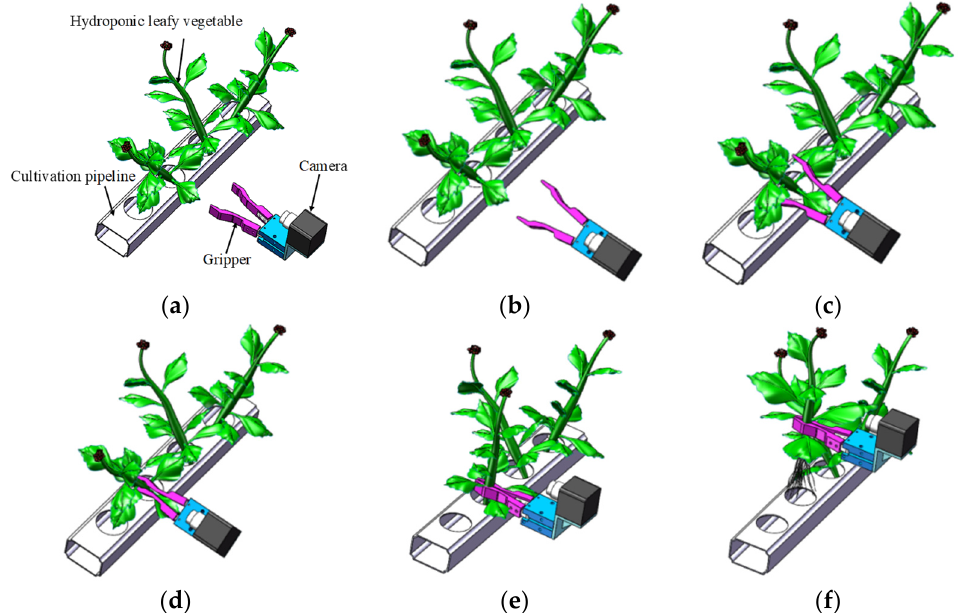
Figure 1. Vision technology process of grabbing a leafy hydroponic vegetable: ( a ) recognize and locate the grabbable area, ( b ) adjust the position and orientation of the gripper, ( c ) drive the gripper to the grabbable area, ( d ) close the gripper to grasp the grabbable area, ( e ) adjust the gripper to align the center of the leafy vegetable stalk with the center of the planting hole, and ( f ) draw the gripper along the center direction of the planting hole to move the root of the leafy vegetable out of the planting hole.